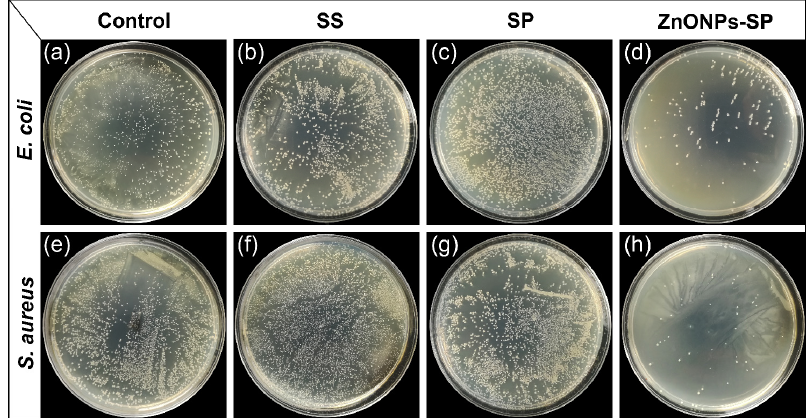
Figure 6. Bacterial colony counting assay. The antibacterial performance of control, sericin, SP, and ZnONPs-SP sponge against E. coli ( a – d ) and S. aureus ( e – h ). LB medium was used as the control.